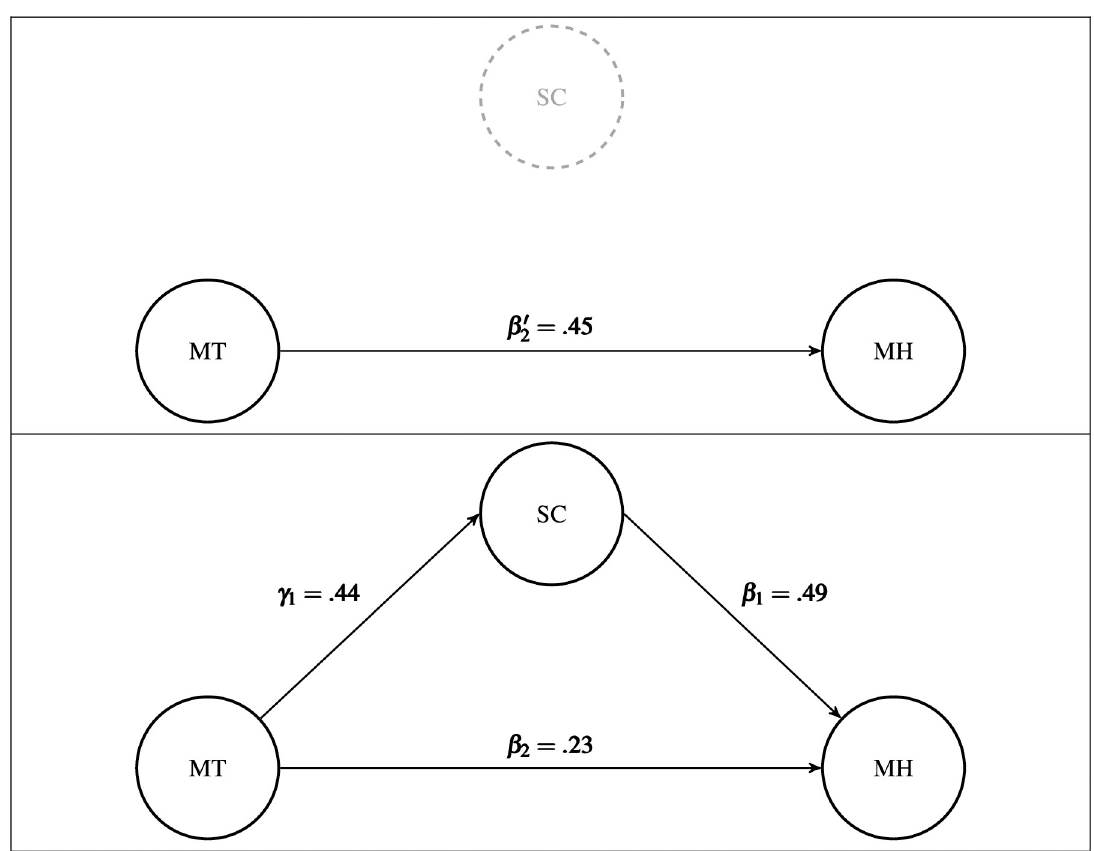
(cid:0) b ¼ : 45 (cid:0) : 23 ¼ : 22 , which is also equal to the products of the paths with SC ( γ 1 × β 1 = .44 × .49 = .22). 2 2